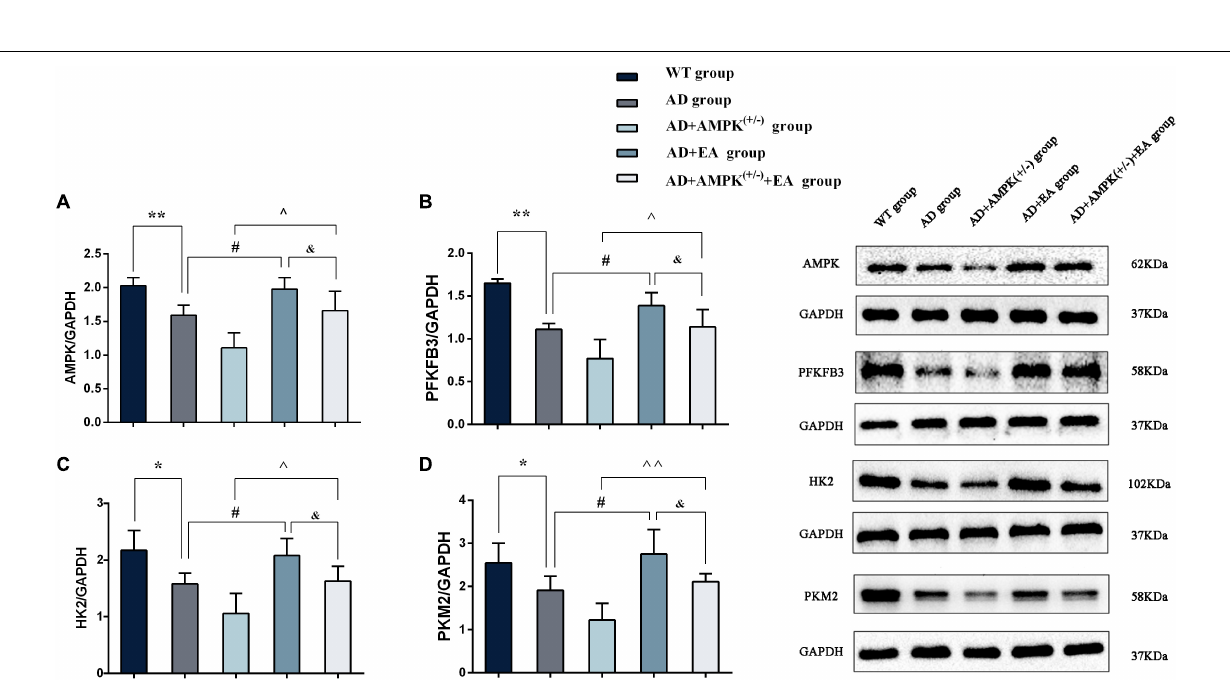
Frontiers in Cellular Neuroscience |